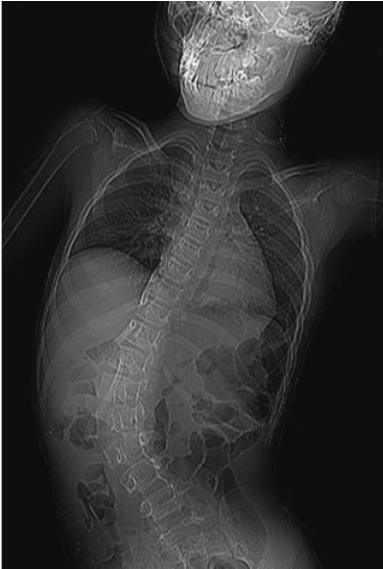
Figure 1: Chest X-ray image shows severe scoliosis.